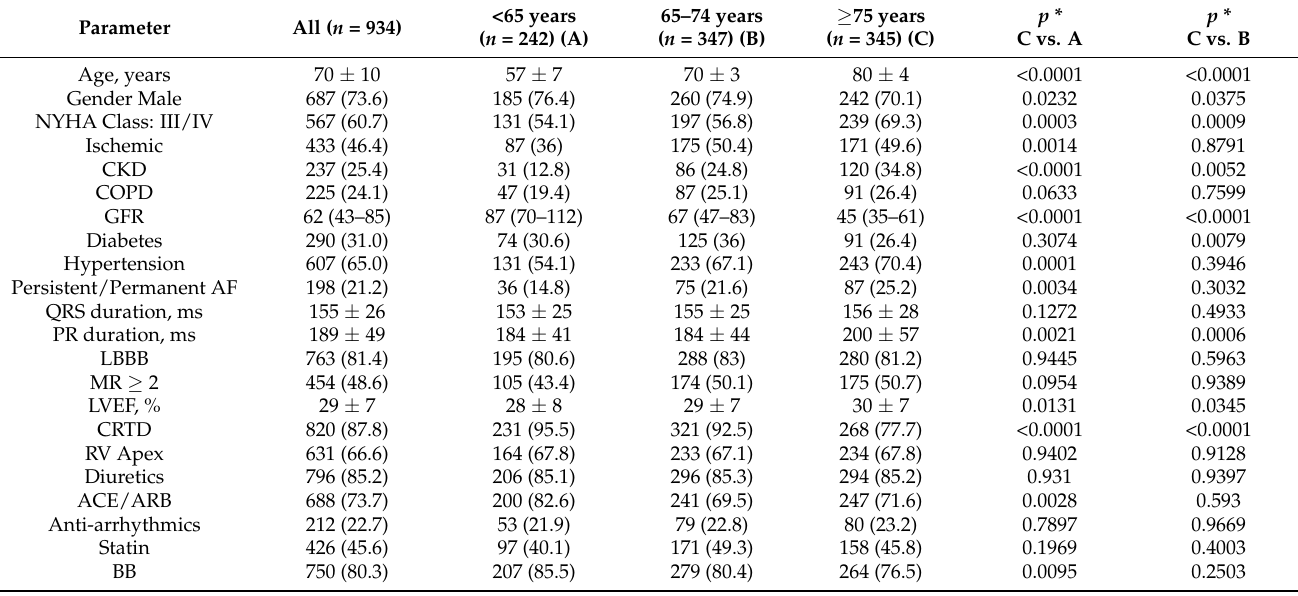
Table 1. Baseline characteristics and Indication Class.